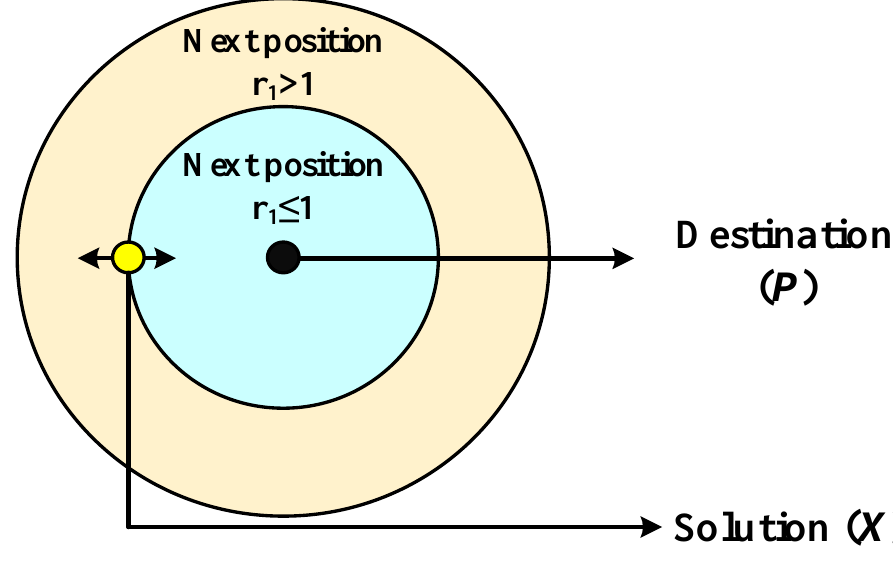
Figure 1. Position update mechanism in SCA